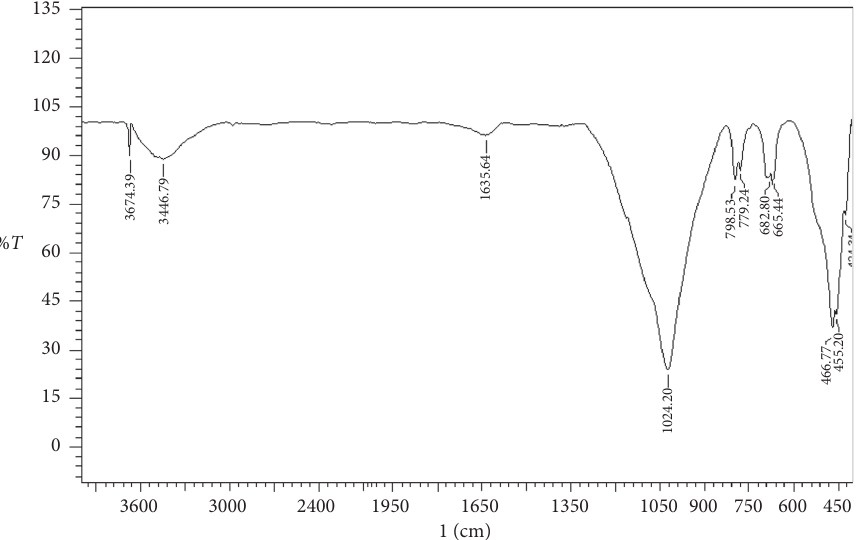
Figure 15: Infrared spectrum of the ZnO/sepiolite composite prepared by the impregnation-reduction method. Table 1: Results of X-ray fluorescence spectrum analysis of sepiolite (measuring unit: ω (B)/10 − 2 ).